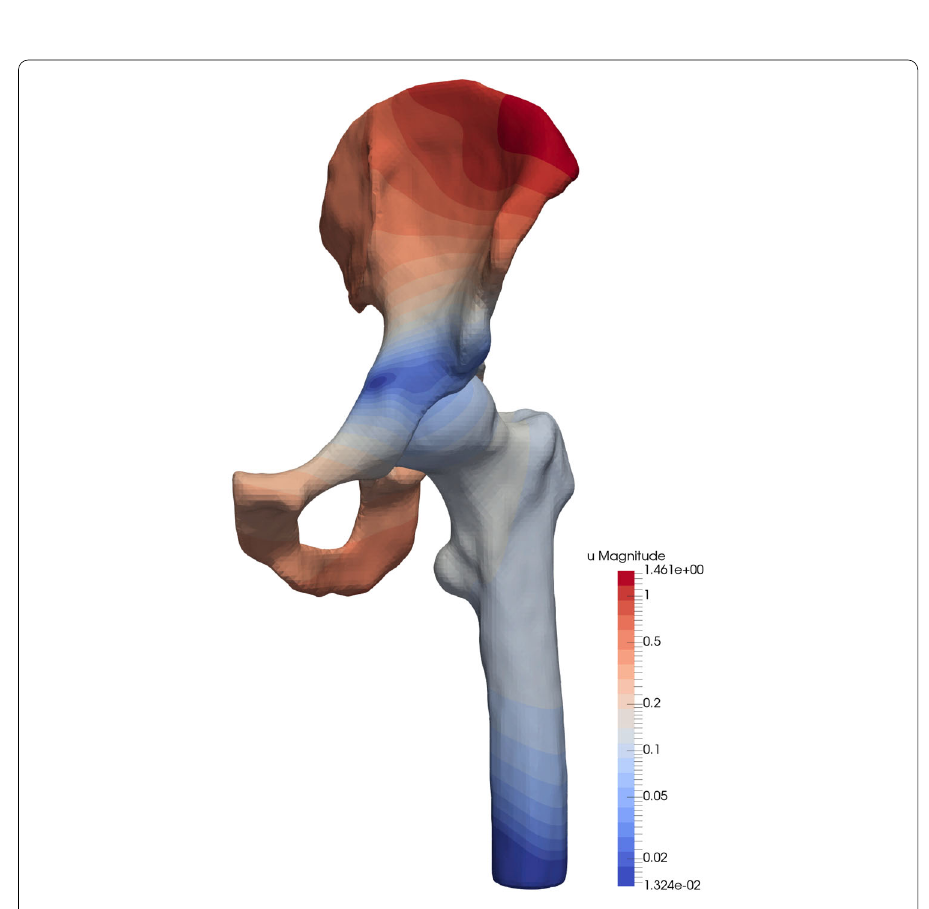
Fig. 13 Magnitude of deformation in hip joint